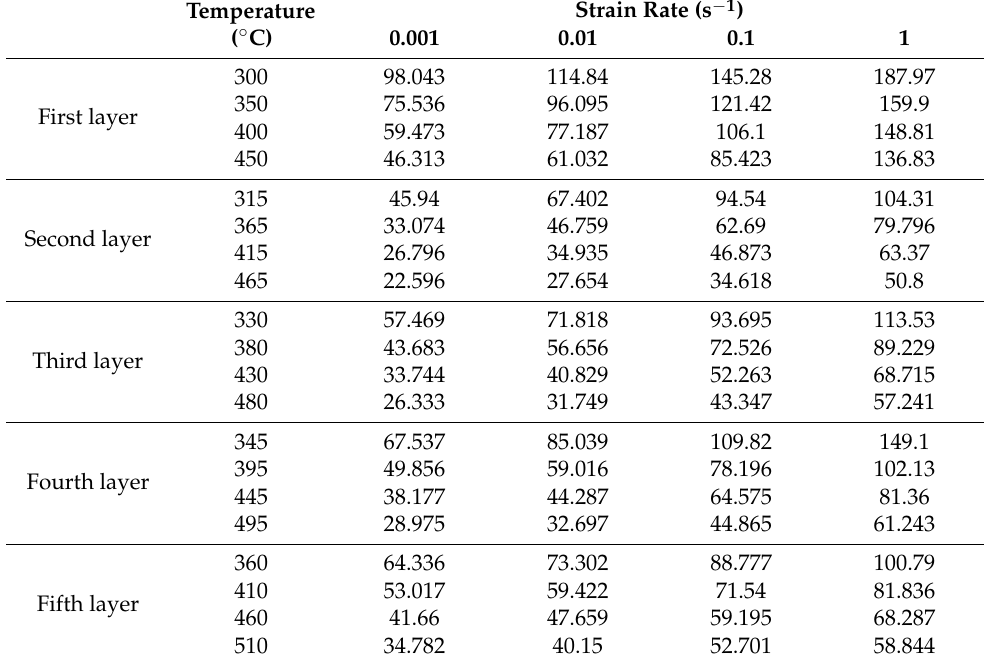
Table 3. Peak stress at different temperatures and strain rates (MPa).